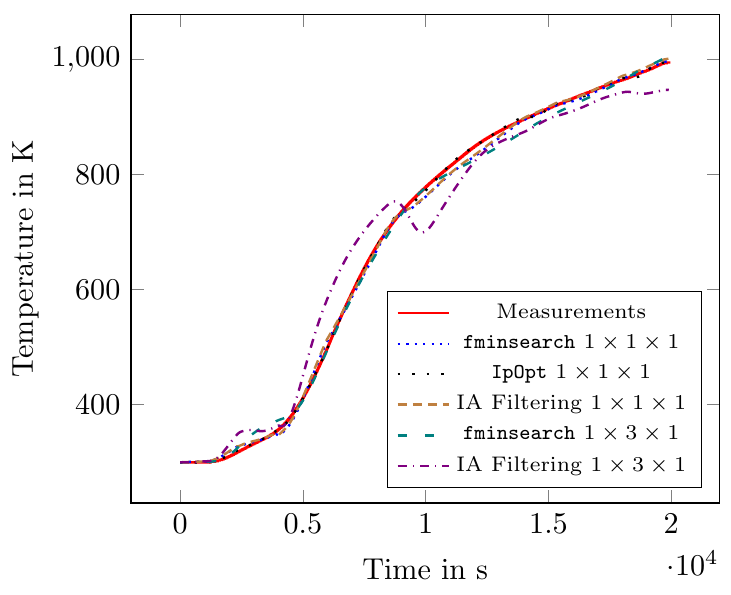
Figure 2. Results for models MQ1, MQ3. MQ1 corresponds to 1 1 3 1. “Fminsearch” denotes results obtained using MATLAB, “IpOPT” the ones using the C++ × × tool from [30], and “IA Filtering” the global